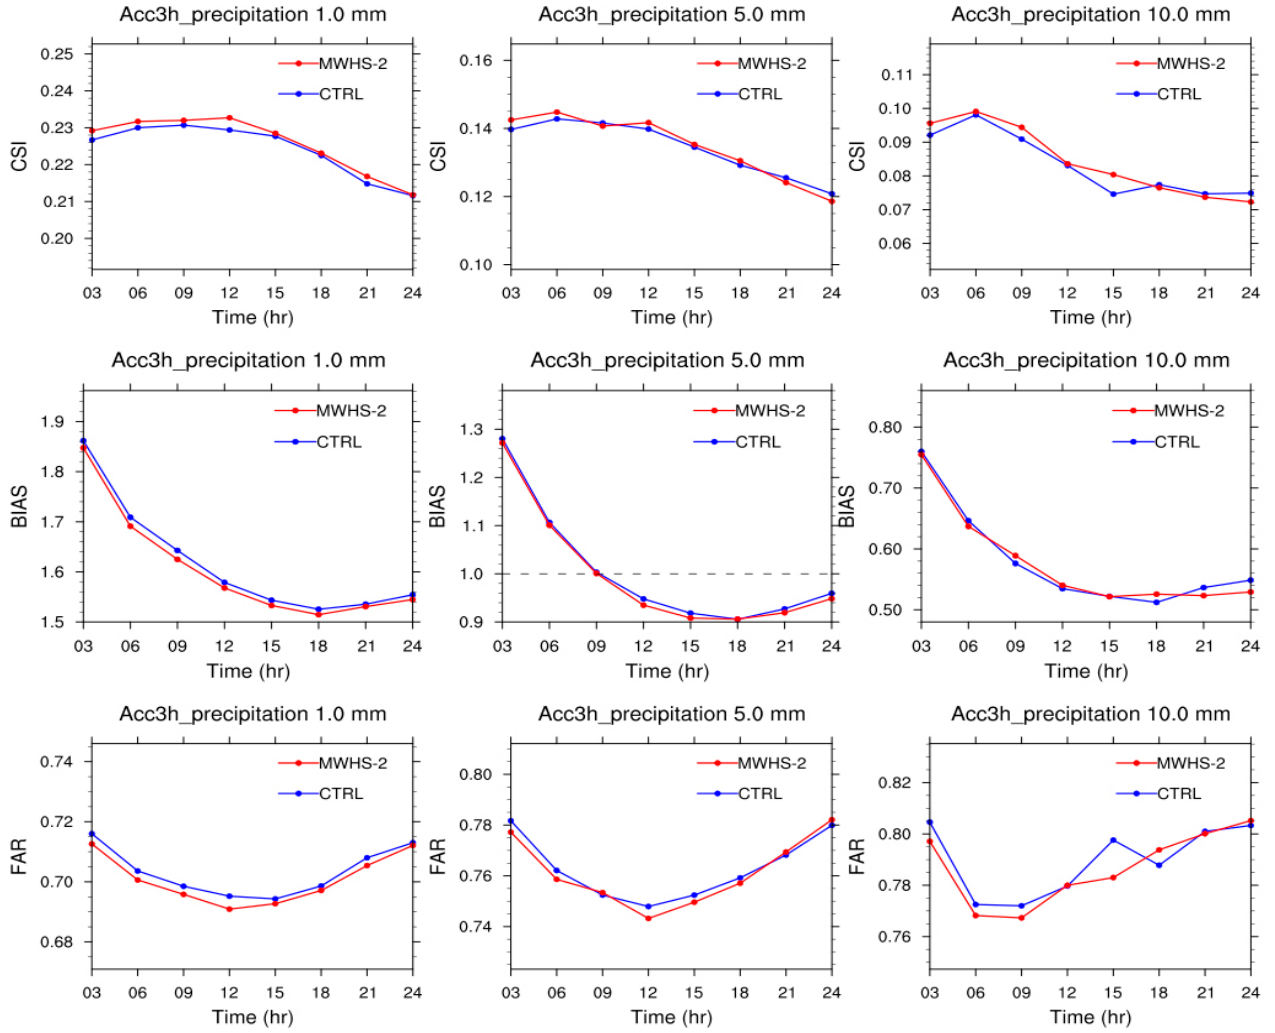
Figure 10. The CSI, BIAS and FAR scores of 3-h accumulated precipitation from the CTRL and the MWHS-2 forecasts in the 9-km domain for the threshold of 1.0 mm, 5.0 mm and 10.0 mm.